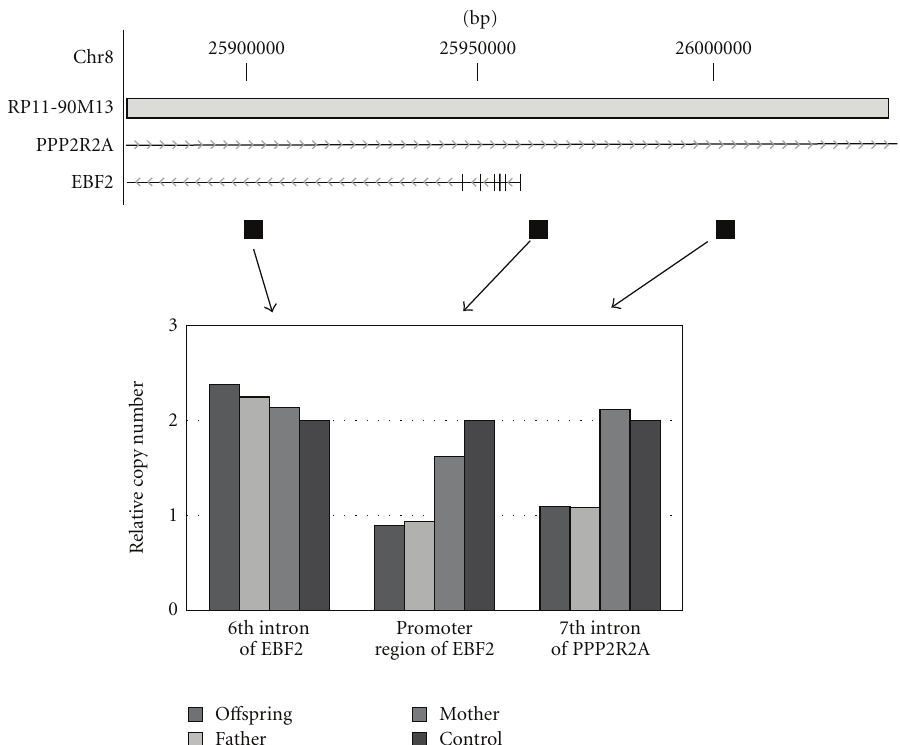
Figure 2: Characterization of a loss-type CNV detected on a BAC-clone RP11-90M13. A genome map of the RP11-90M13-containing region was obtained from the UCSC Genome Browser website. The distance (bp) from the p-terminal of chromosome 8 is shown in the uppermost part. That region contains two genes, protein phosphatase 2, regulatory subunit B, alpha ( PPP2R2A ) and early B-cell factor 2 ( EBF2 ). The positions of PCR primers examined are shown by solid boxes. The individual has variant fragments with a deletion that contains a part of the 7th intron of the PPP2R2A gene and the promoter region of the EBF2 gene.